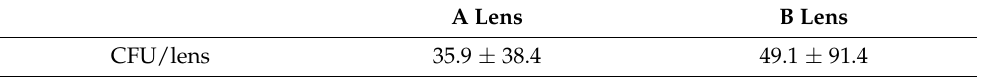
Table 3. Number of bacteria adhering to the BCLs after continuously wearing them for 24 h.